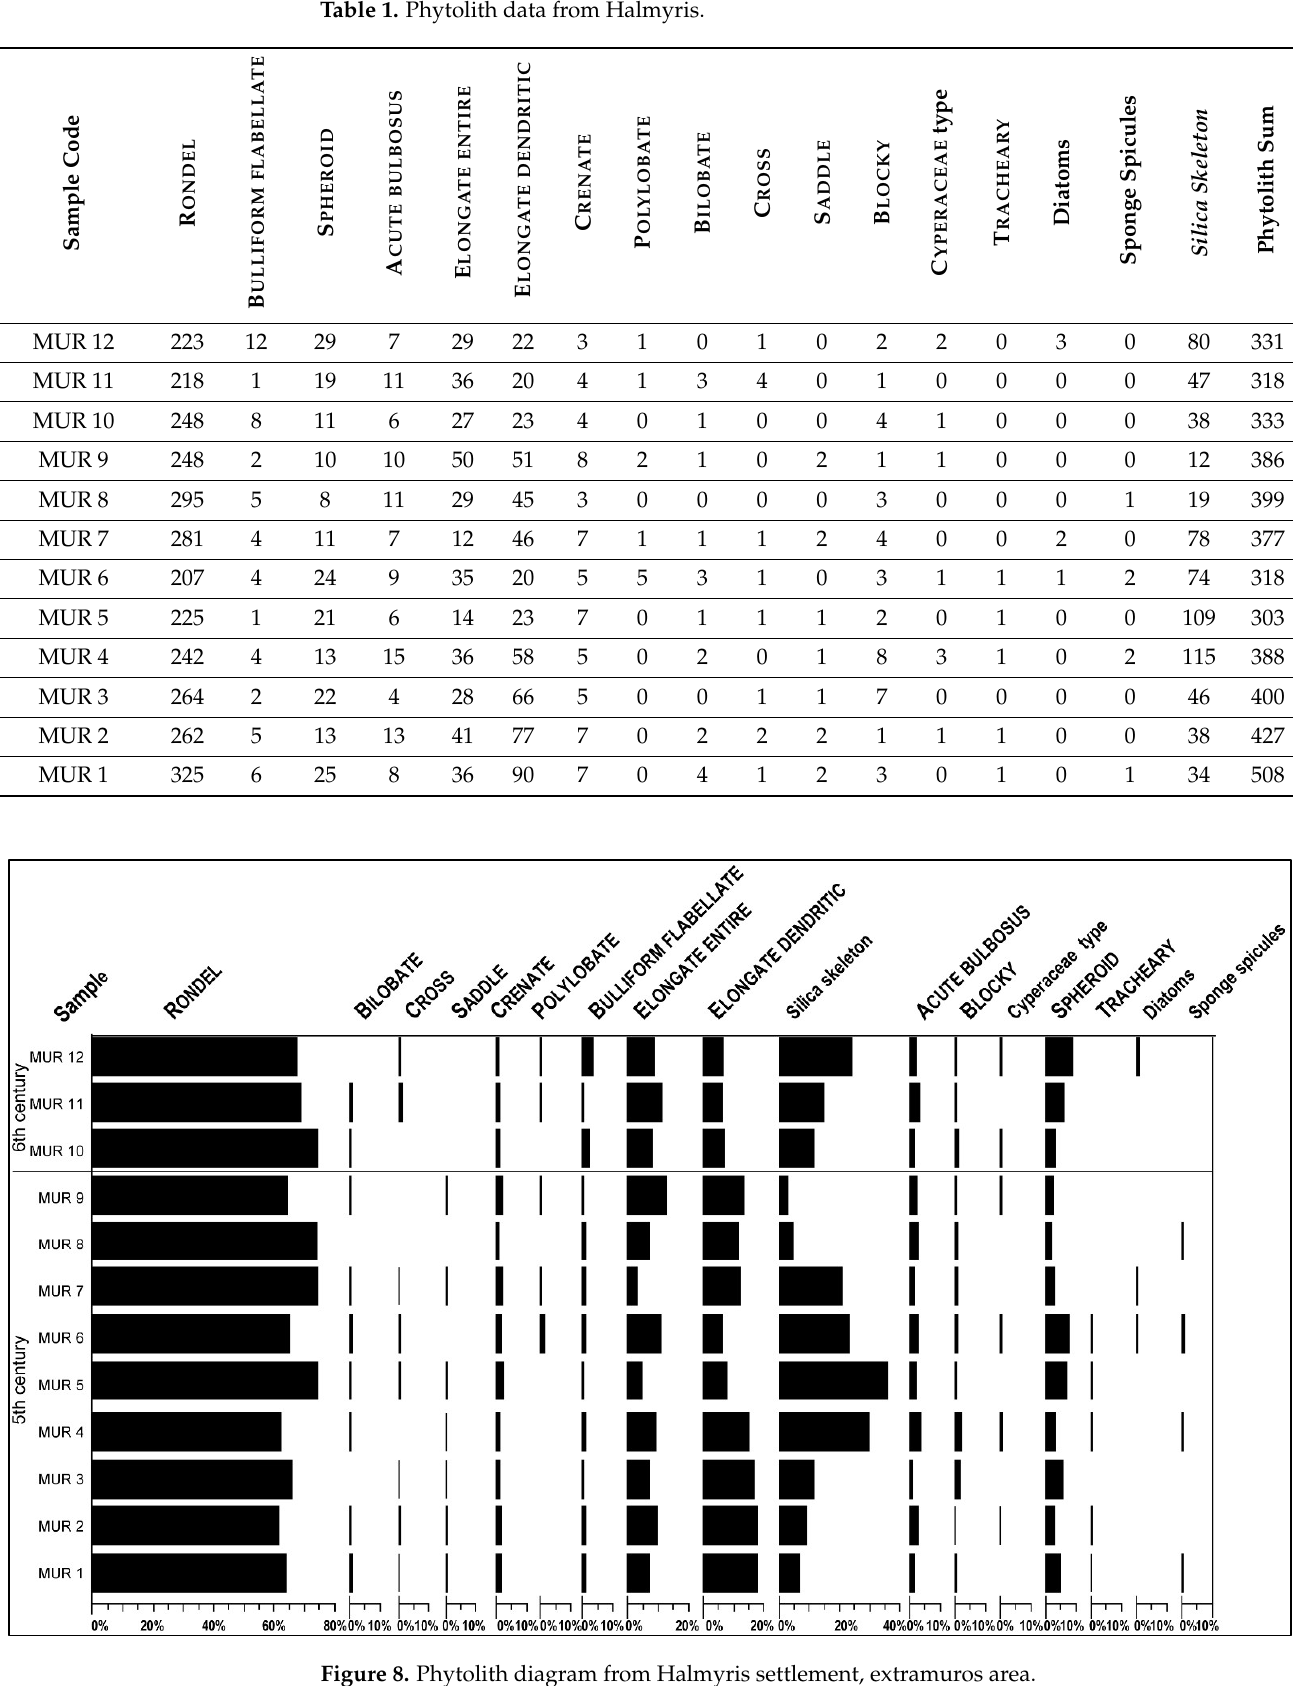
Figure 8. Phytolith diagram from Halmyris settlement, extramuros area.